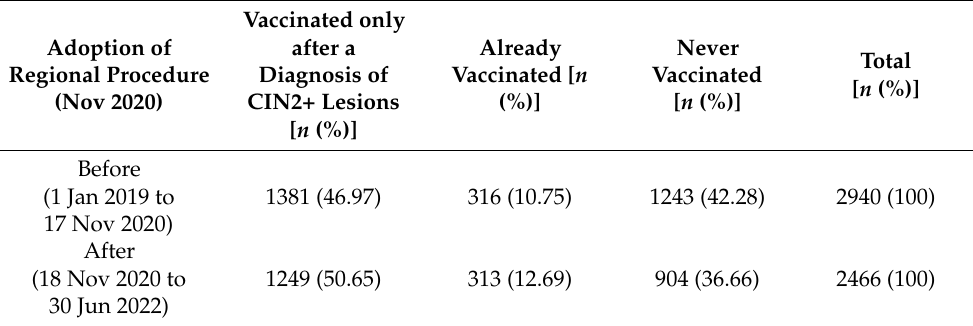
Table 4. Distribution of women diagnosed with CIN2+ lesions at cervical screening, by HPV vaccina- tion status, before and after the introduction of the regional